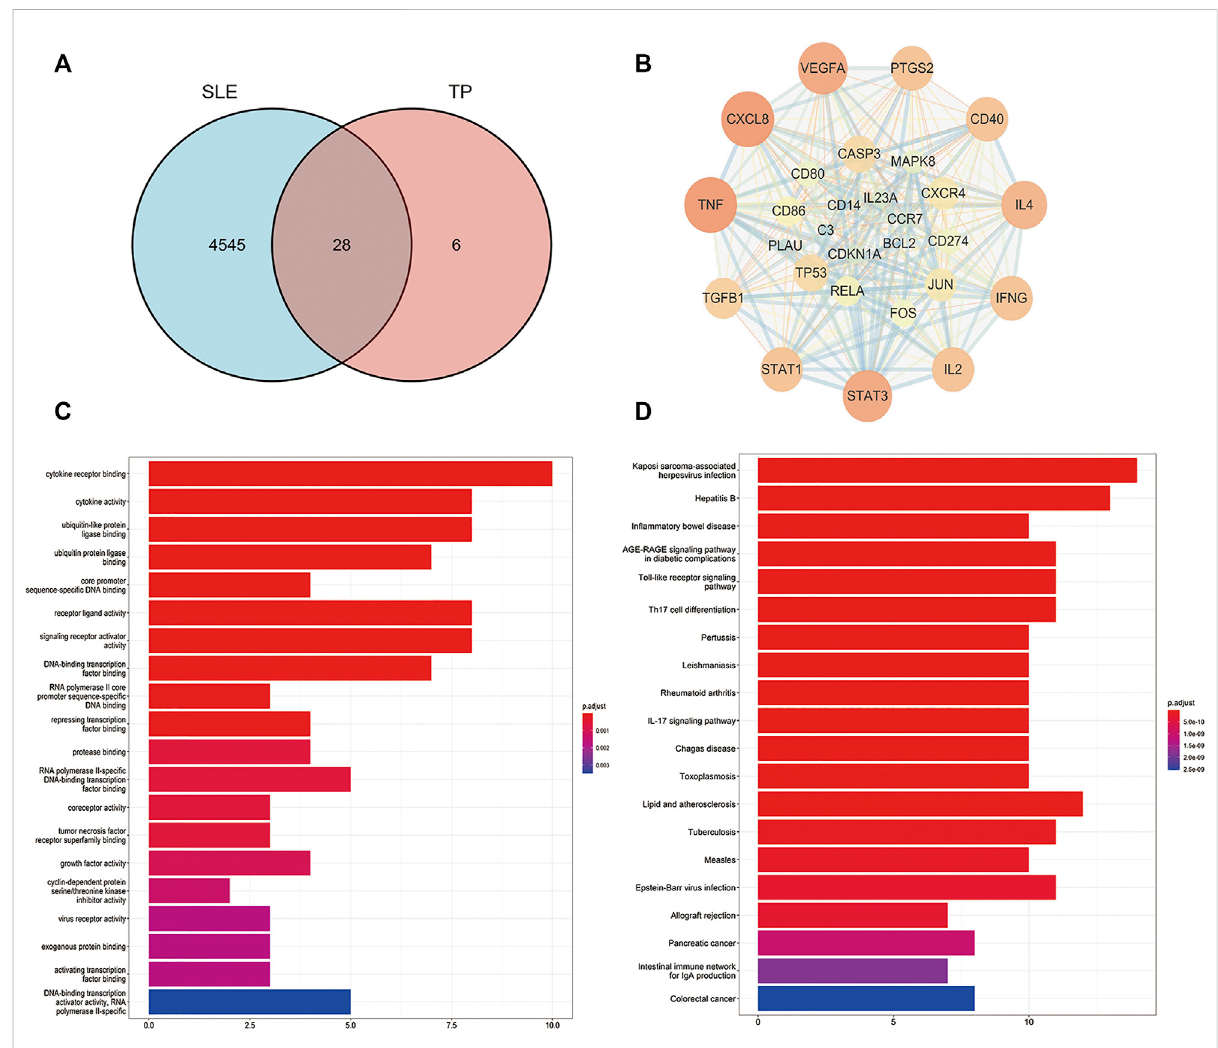
Network pharmacological analysis of the overlapping targets of TP and SLE. (A) Venn diagram of the compound targets of SLE and TP. (B) VisualizationoftheintersectiontargetsofTPand SLEusingCytoscape3.7.1software.The dotsrepresent thetargetofTPinthetreatment ofSLE and the edges represent the interactions between targets. (C) Gene ontology (GO) analysis of the overlapping targets of TP and SLE. (D) Kyoto Encyclopedia of Genes and Genomes (KEGG) analysis of the overlapping targets of TP and